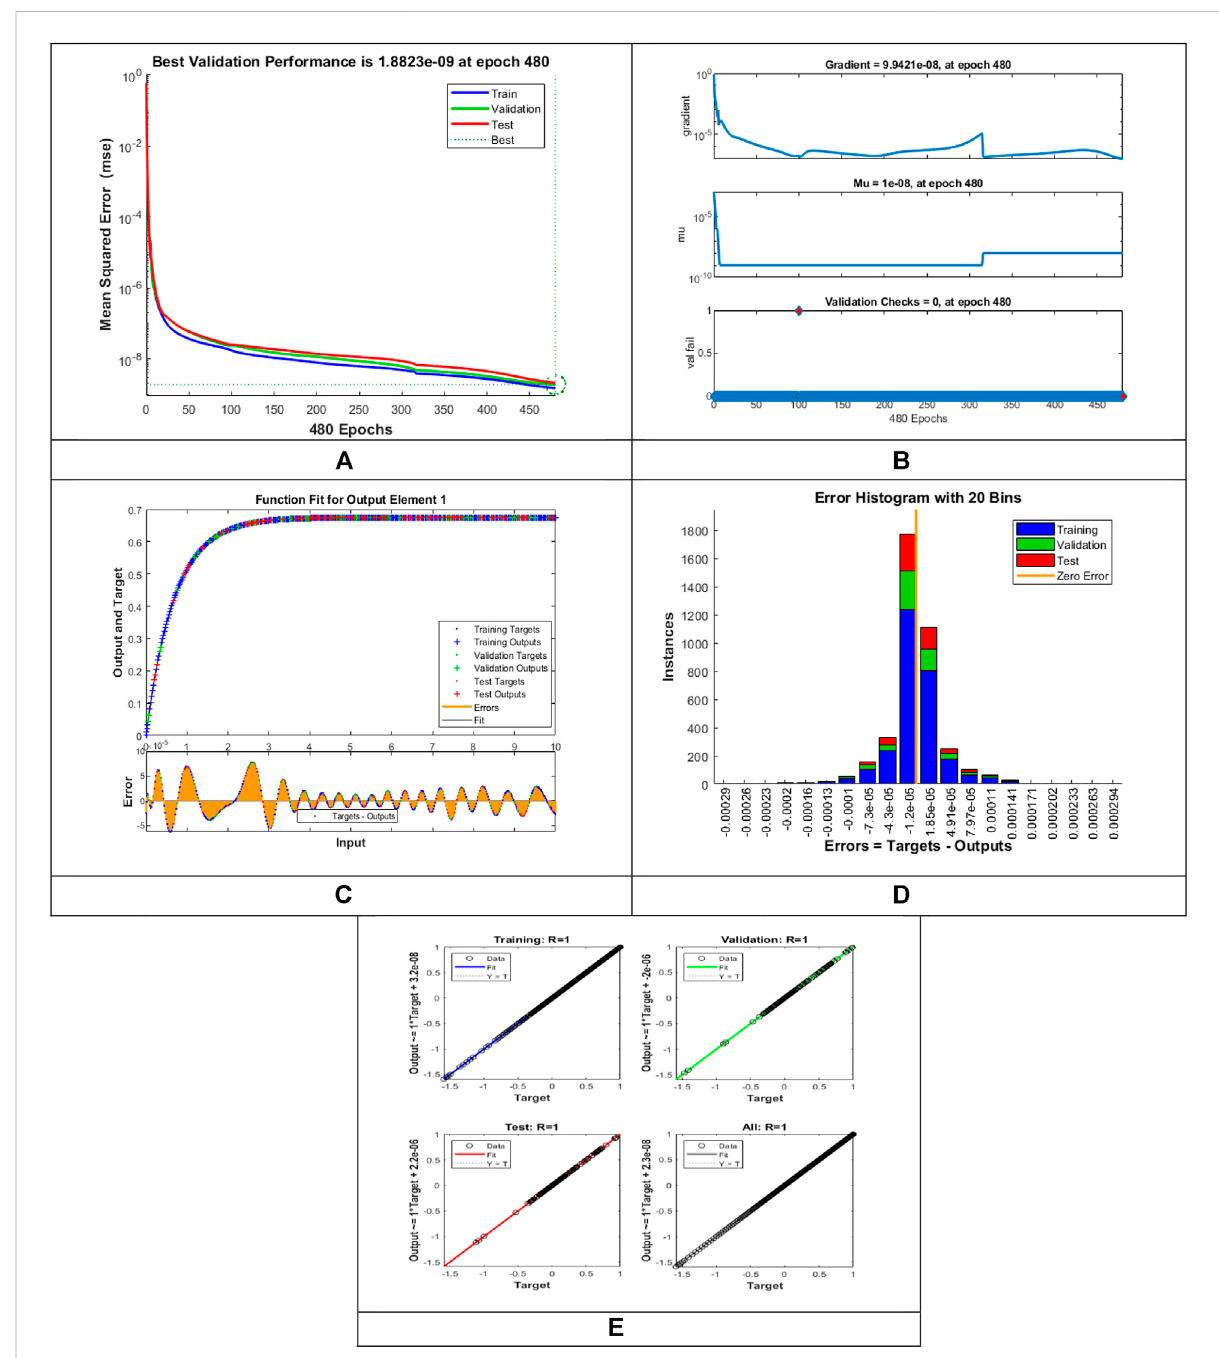
FIGURE 10 Pictorial illustration for the LMLA-BPNN base on variants of Nt vs ϕ ( η ) for MHD-WNF-HGA. (A) M-S-E demonstration, (B) transition state analysis, (C) curve fi tting, (D) error histogram, and (E) regression analysis.